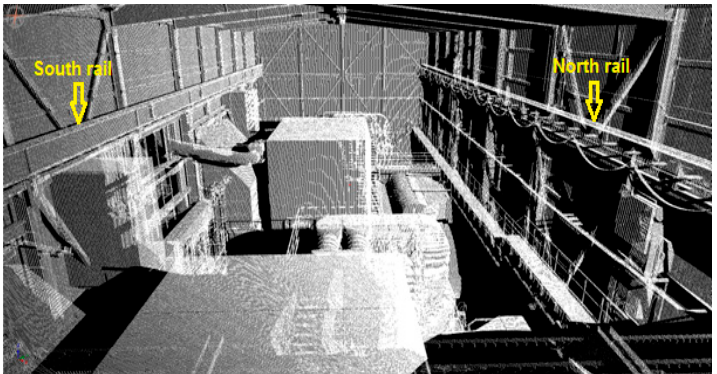
Figure 7. Point cloud in the gas block hall.